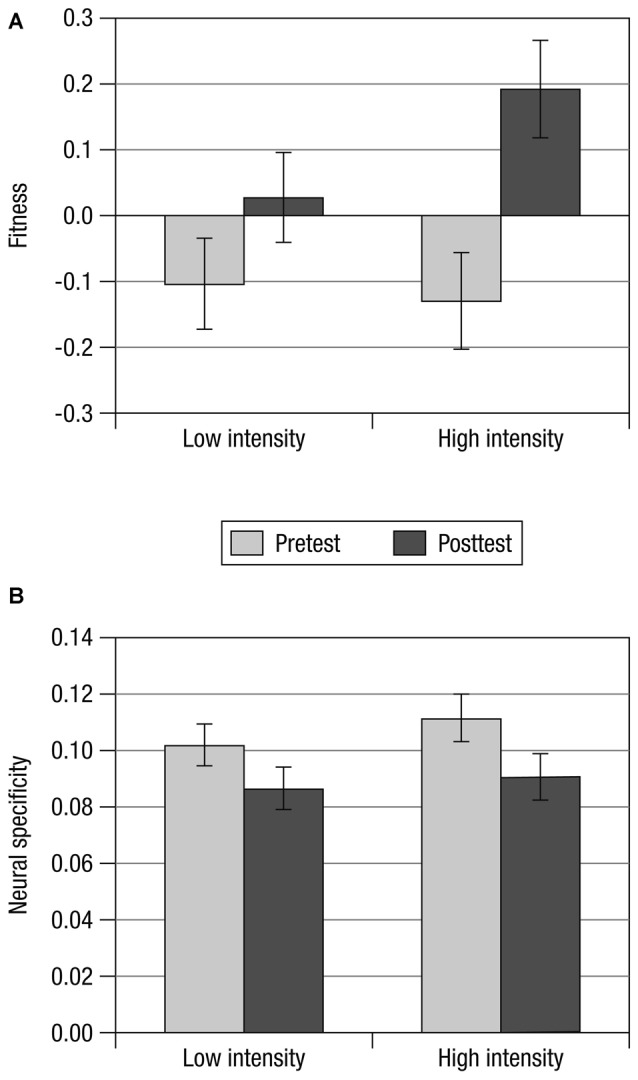
Mean changes over the course of the training in (A) fitness (aggregate measure of VO2max and VO2AT) and (B) neural specificity. Whereas fitness increased reliably from pretest (light gray) to posttest (dark gray), changes in neural specificity were not significantly different from zero. For both measures, changes in the LI training group (left) were not reliably different from changes in the HI training group (right). Error bars depict the standard error after removing between-person variability (Cousineau and O’Brien, 2014).